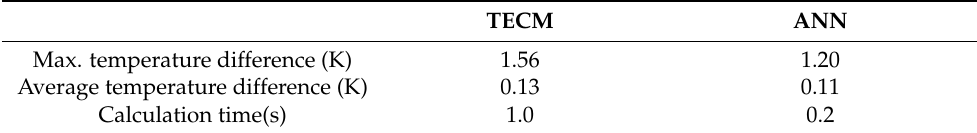
Figure 18. Comparison of TECM and ANN model. Table 12. Comparison of temperature deviation of two models.